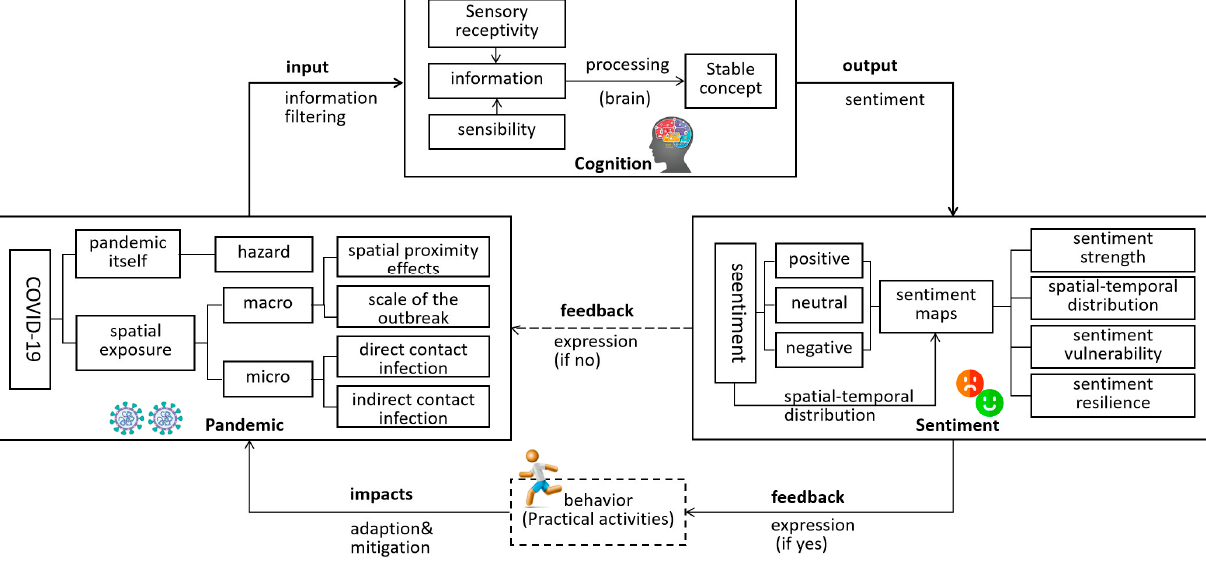
Figure 2. Pandemic-cognition-sentiment (PCS) conceptual model.